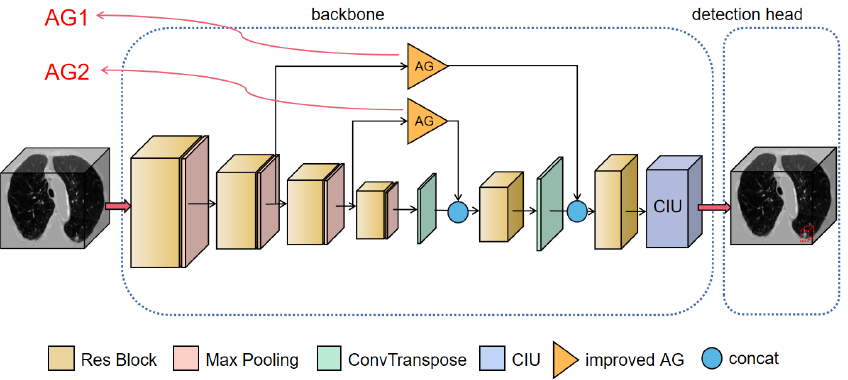
Figure 1. Scheme of the proposed channel-wise attention nodule detection network